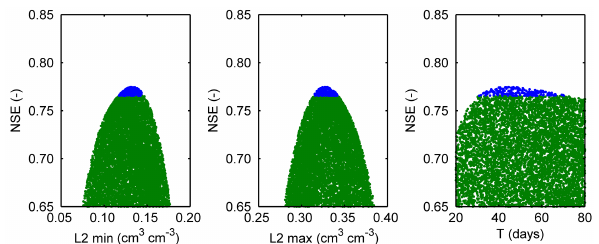
Figure 8. Sensitivity of the exponential filter parameters. Parame- ters were optimized based on the NSE. The blue dots indicate the top 200 combinations with the highest NSE, giving an indication of the sensitivity.